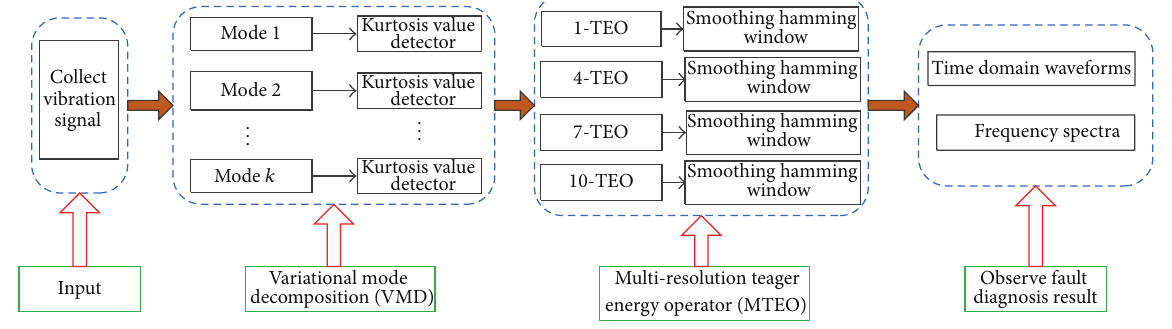
Figure 1: Flow chart of the proposed scheme for weak faulty signal.